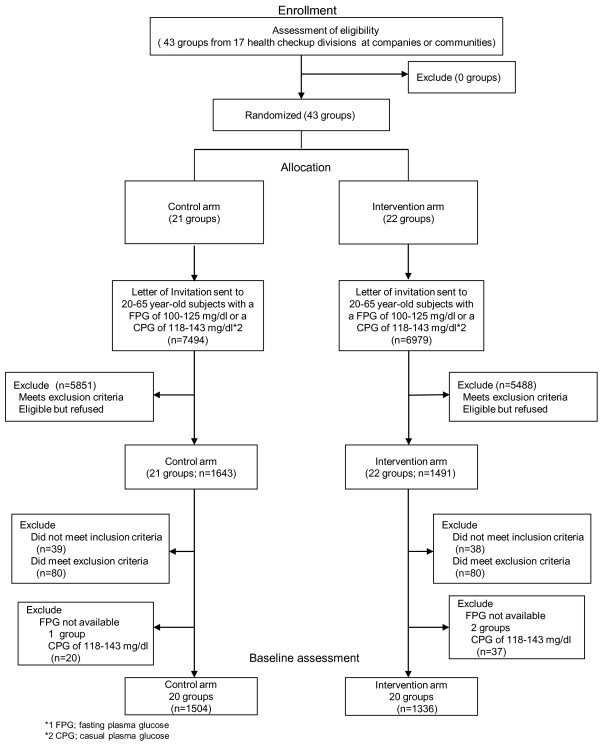
Flowchart of participant recruitment and trial design: main scheme (n=2840).